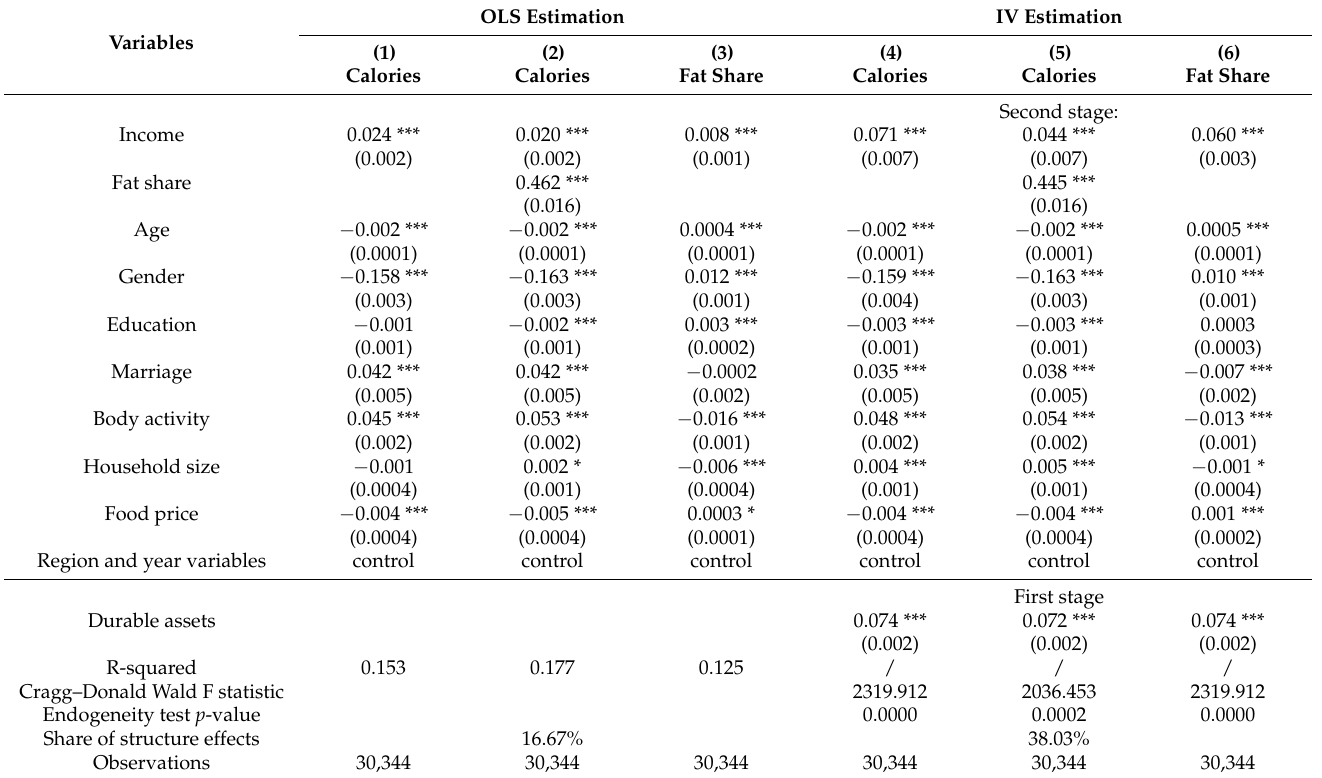
Table 2. The results from the OLS estimation and IV estimation.